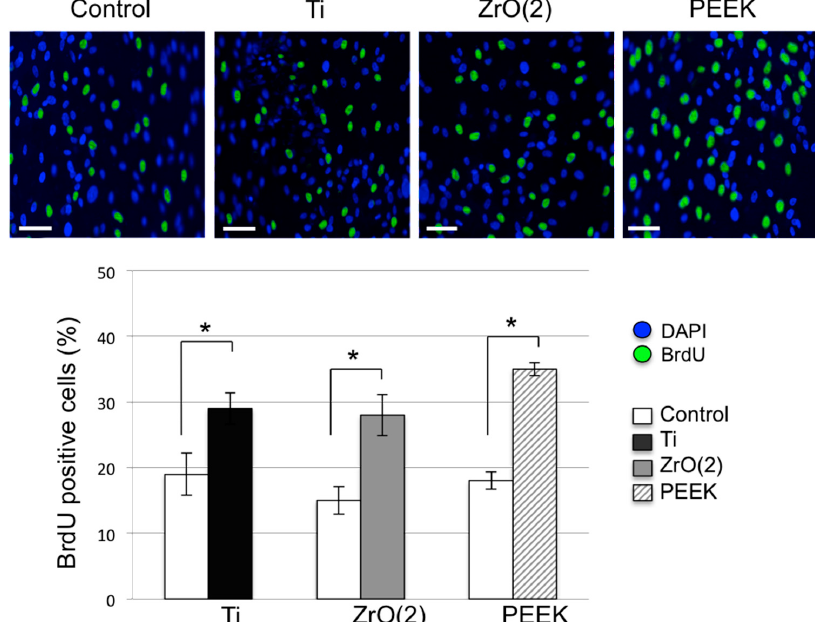
Figure 3. BrdU results (means ± SD, n = 3) represent cellular BrdU incorporation into DNA in arbitrary units after seven days of growth over group disc surfaces compared with control disc. Scale bar: 50 μ m, * p < 0.05. Materials 2016